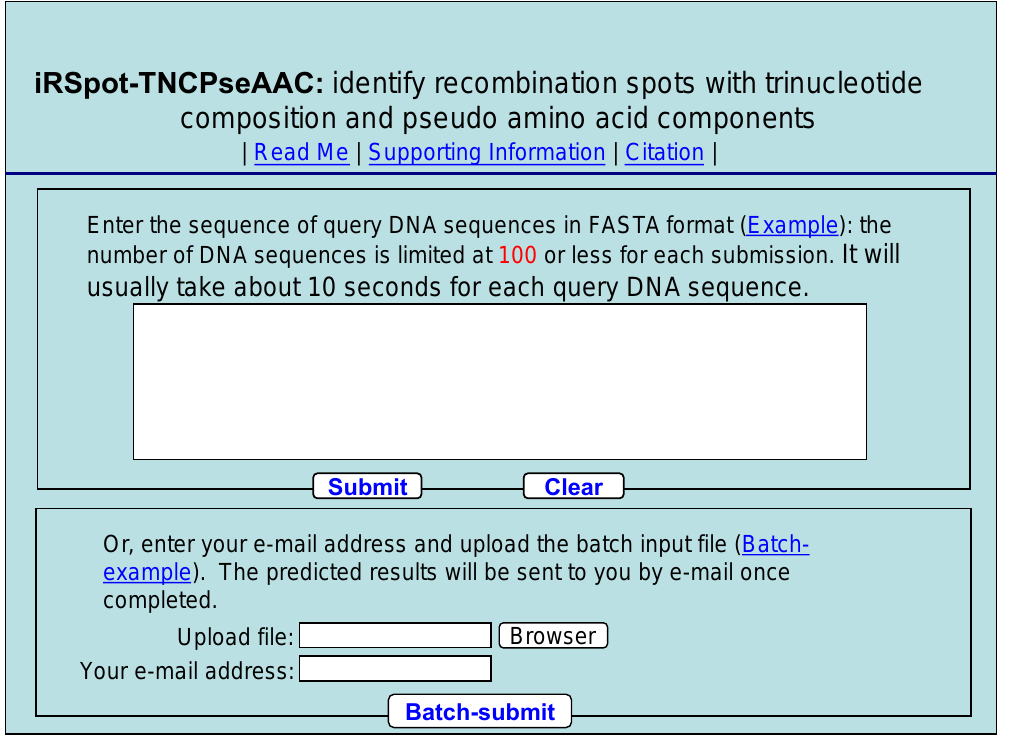
Figure 3. The input sequence should be in the FASTA format. For the examples of sequences in FASTA format, click the Example button right above the input